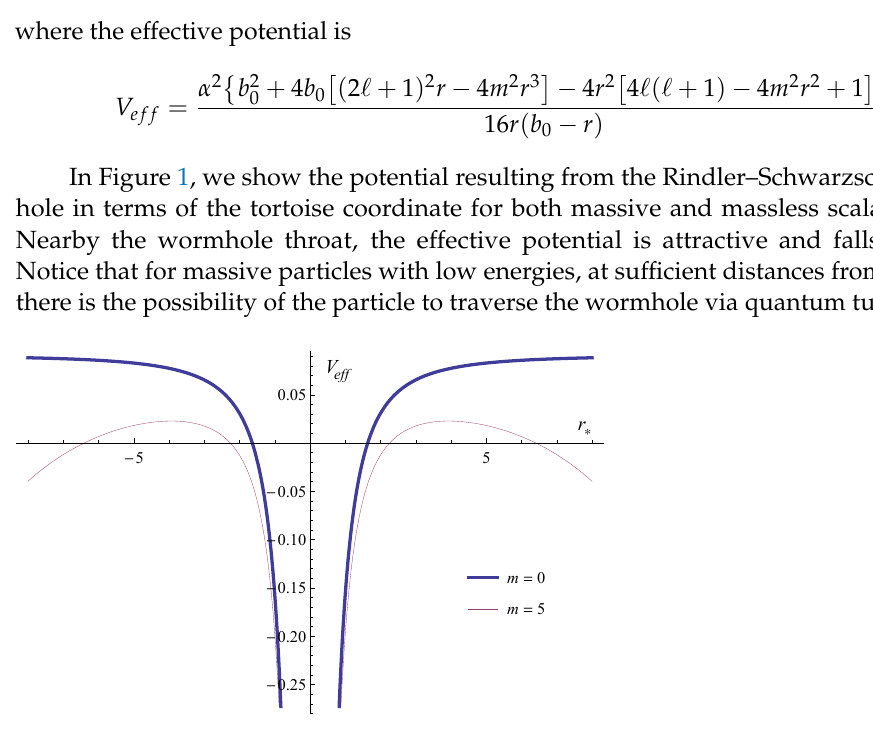
Figure 1. Effective potential for both massive and massless scalar fields around the Rindler– Schwarzschild wormhole ( q = 2), with α = 0.2, (cid:96) = 1 and b 0 = 0.2 in Planck